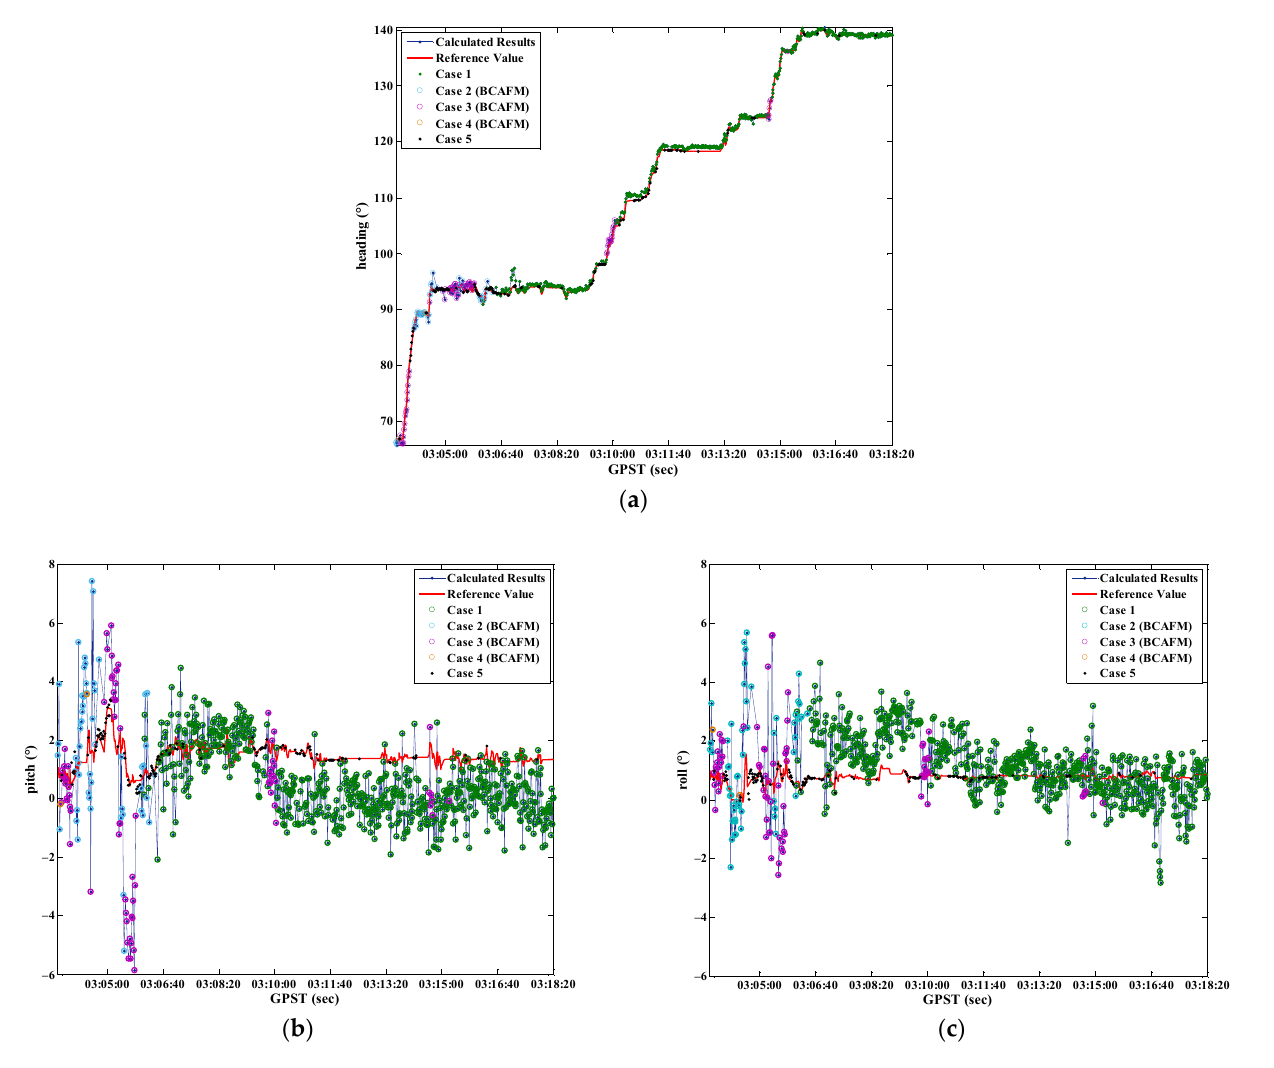
Figure 12. Three attitude angles calculated by BCAFM and the reference values. ( a ) Heading; ( b ) Pitch; ( c ) Roll.